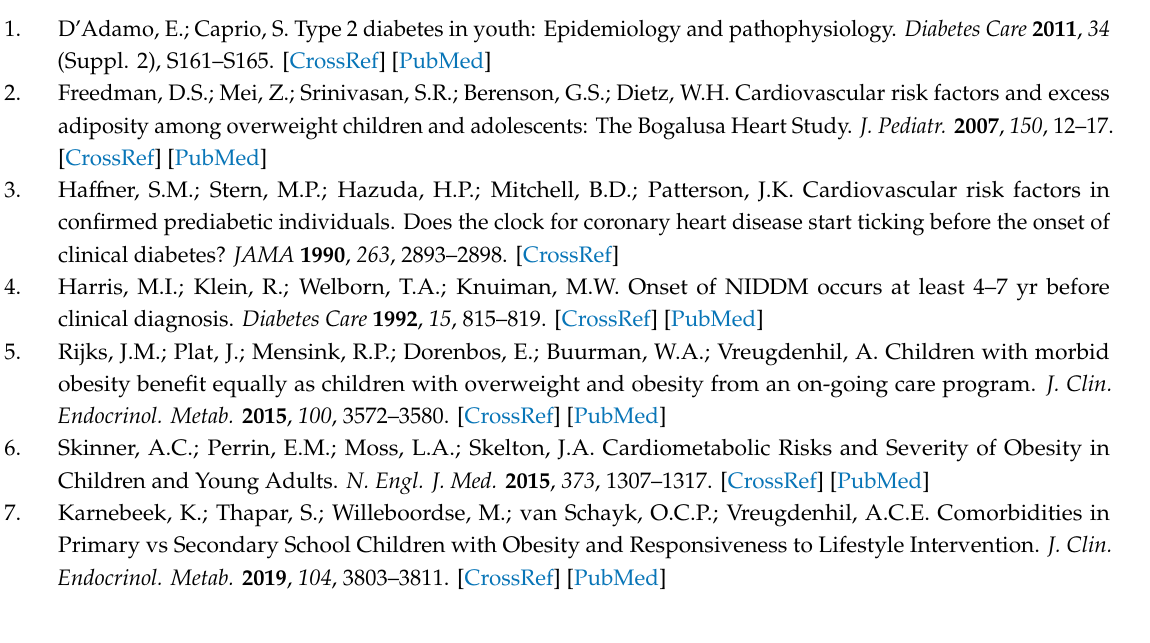
Table S1: 48-hour sensor glucose measurements at baseline and after 12 months of lifestyle intervention; Table S2: 48-hour sensor glucose measurements at baseline and after 12 months of lifestyle intervention. Table S3: Correlation coe ffi cients between baseline characteristics and sensor glucose measurements—subgroup analysis for the children with an increase in BMI z